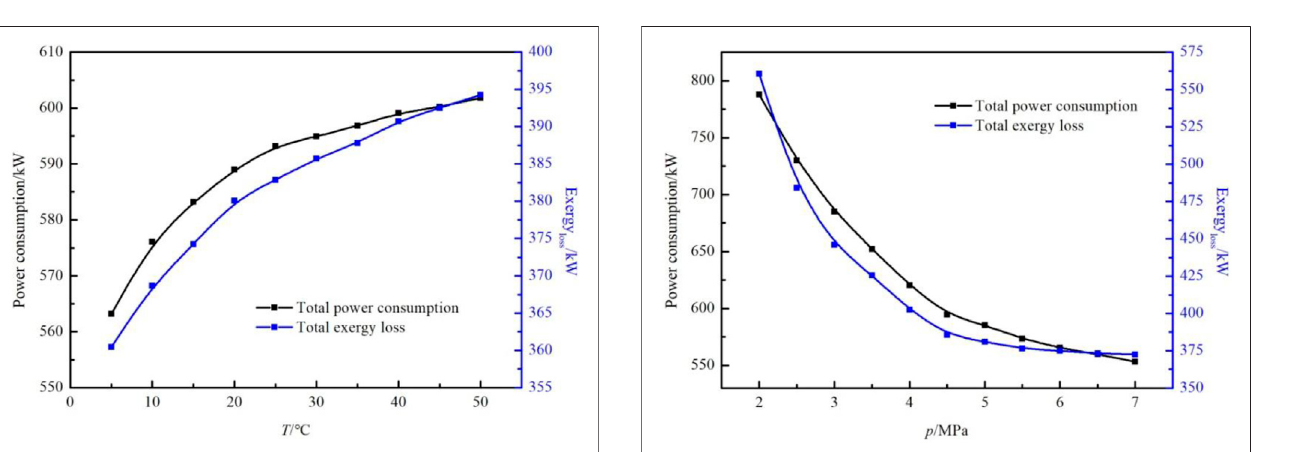
FIGURE 5 | In fl uence of natural gas pressure on power consumption and exergy loss of the system.